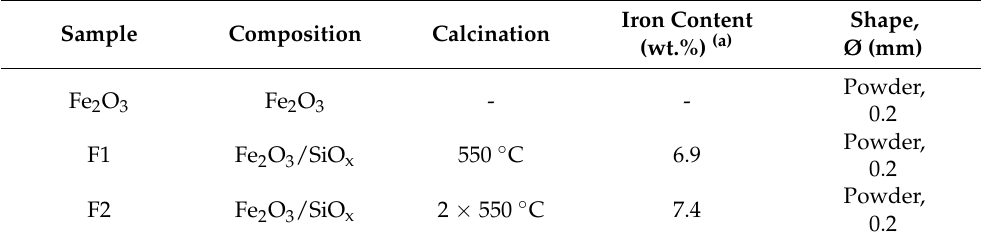
Table 1. Characteristics of the Fe 2 O 3 /SiO x catalysts obtained by sol–gel preparation followed by thermal treatment (calcination) and control samples.